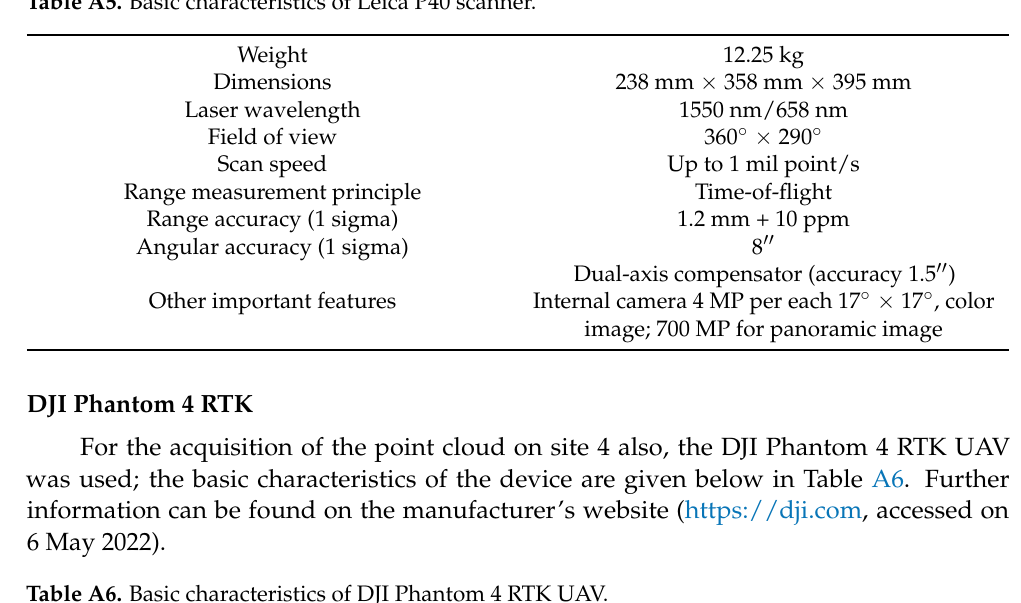
Table A5. Basic characteristics of Leica P40 scanner.